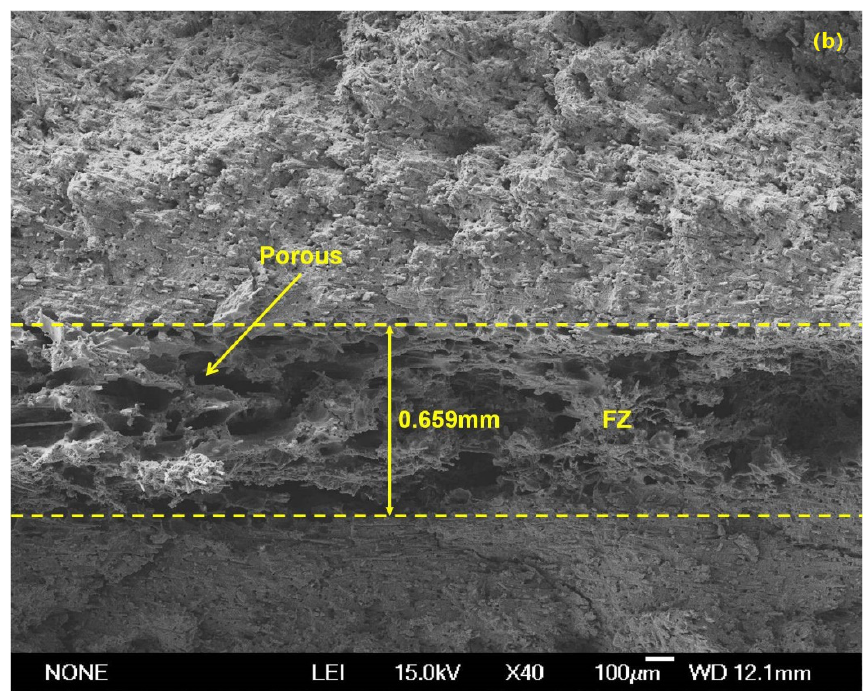
Figure 12. Microstructure of UW joints at weld time of 1.7 s ( a ) normal clamp ( b ) PPRC.